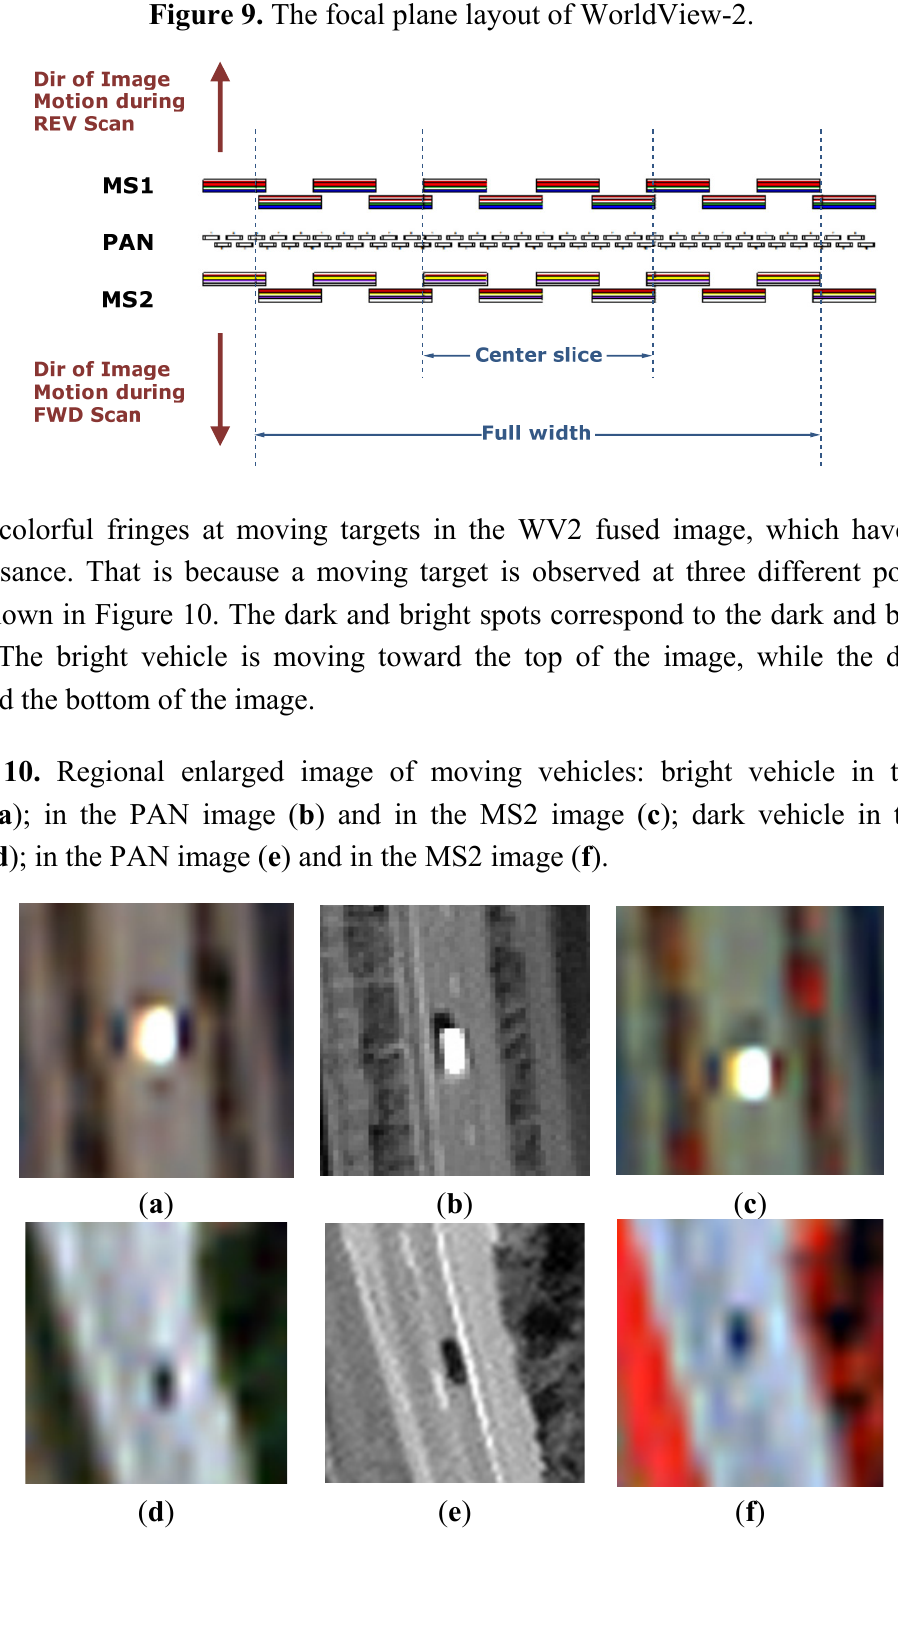
Figure 9. The focal plane layout of WorldView-2.